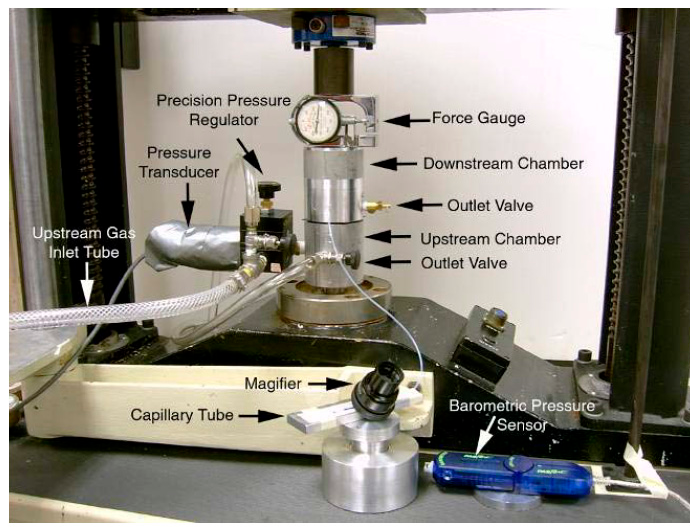
Figure 24. Permeability Test Facility [108].